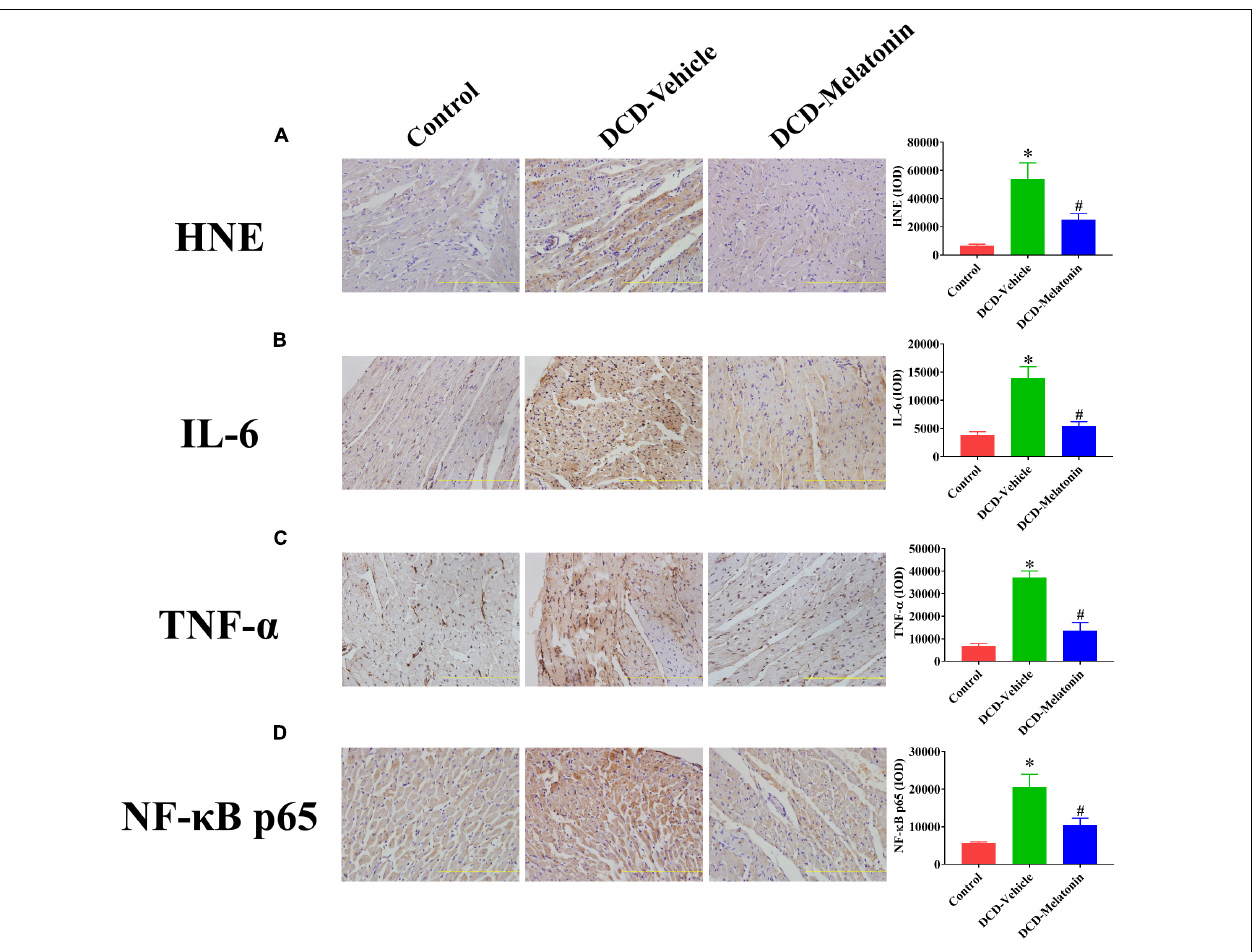
FIGURE 5 | The expression of HNE, IL-6, TNF- α , and NF- κ B p65 in the DCD heart preserved with EVHP. Representative photomicrographs and quantitative analysis of immunohistochemistry for (A) HNE, (B) IL-6, (C) TNF- α , and (D) NF- κ B p65 in the DCD heart. Data represent mean ± standard error of the mean. n = 6–8 for each group. DCD, donation after circulatory death; EVHP, ex vivo heart perfusion; HNE, 4-hydroxynonenal; IL-6, interleukin-6; IOD, integrated optical density; TNF- α , tumor necrosis factor- α ; NF- κ B, nuclear factor kappa-B. ∗ p < 0.05 vs. Control; # p < 0.05 vs. DCD-vehicle.